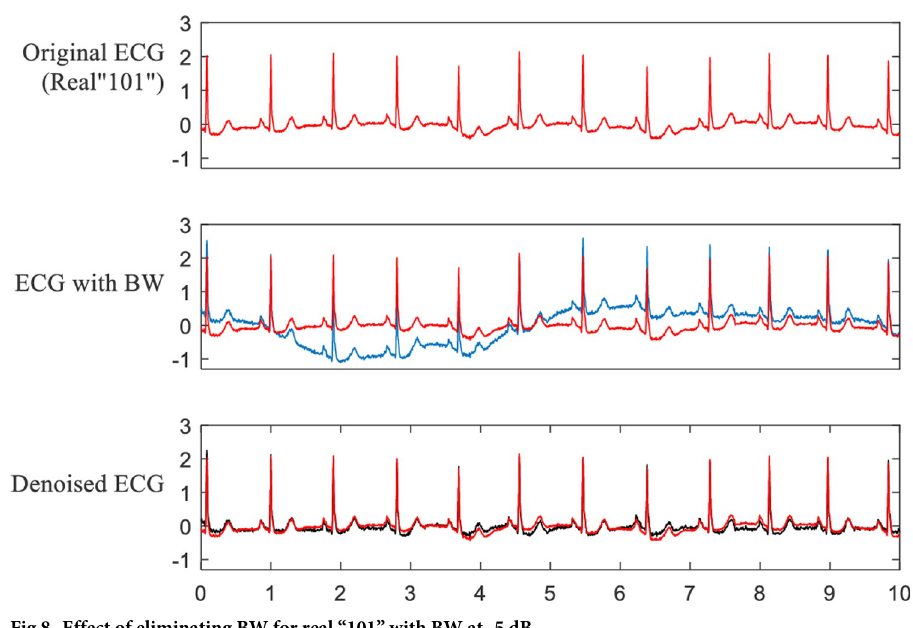
Fig 8. Effect of eliminating BW for real “101” with BW at -5 dB.